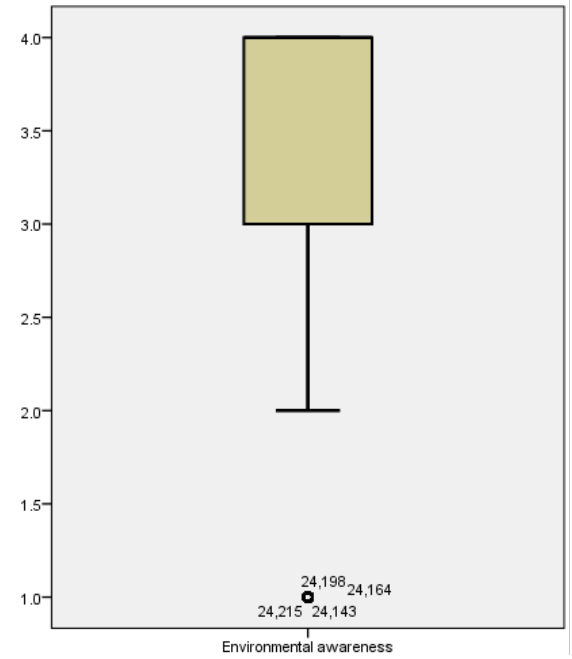
Figure 1. Boxplot of environmental awareness.